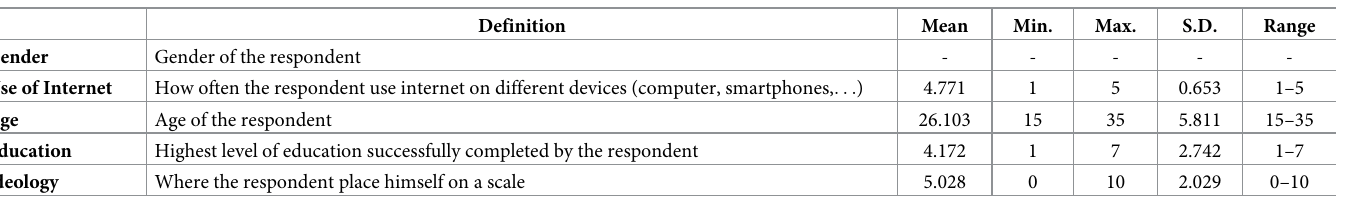
Table 3. Moderating variables. Descriptive statistics.